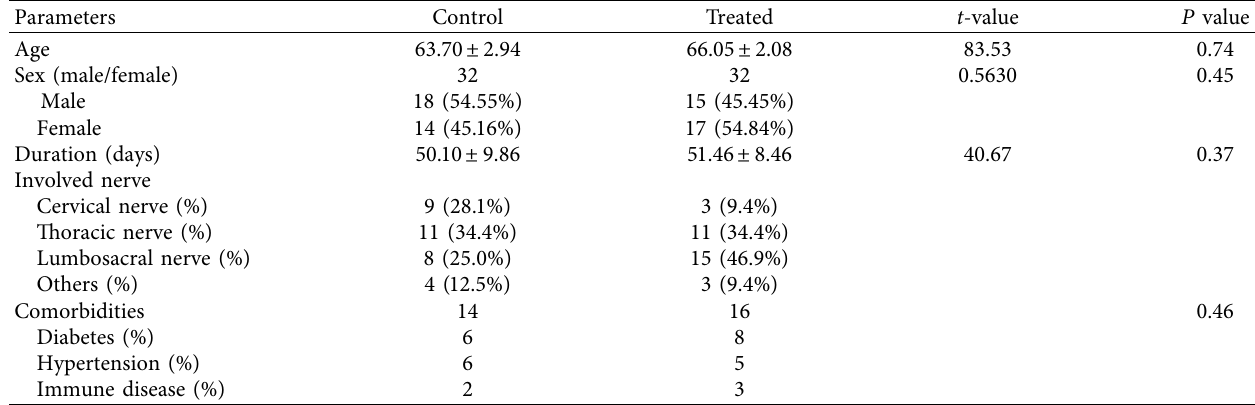
Table 1: Comparison of general information between two groups of patients.